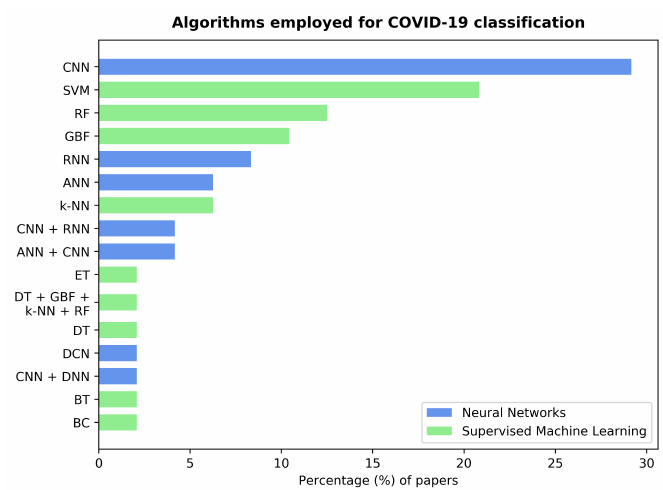
Figure 5. Bar graph showing the percentage of papers employing different classifier algorithms or ensembles. The colors of the bars highlight the type of algorithm, with 54% of the papers using neural network-based algorithms and 48% of them using supervised machine learning. Note that some studies report results with several algorithms (see Table 1); thus, the sum of these percentages exceeds 100%. Legend ⇒ Convolutional Neural Network (CNN), Support Vector Machine (SVM), Random Forests (RF), Gradient Boosting Framework (GBF), Recurrent Neural Network (RNN), Feedforward Neural Network (FNN), k-Nearest Neighbors (k-NN), Extremely randomized Trees (ET), Decision Tree (DT), Dense Convolutional Network (DCN), Dense Neural Network (DNN), Bagged Tree (BT), and Binary Classifier